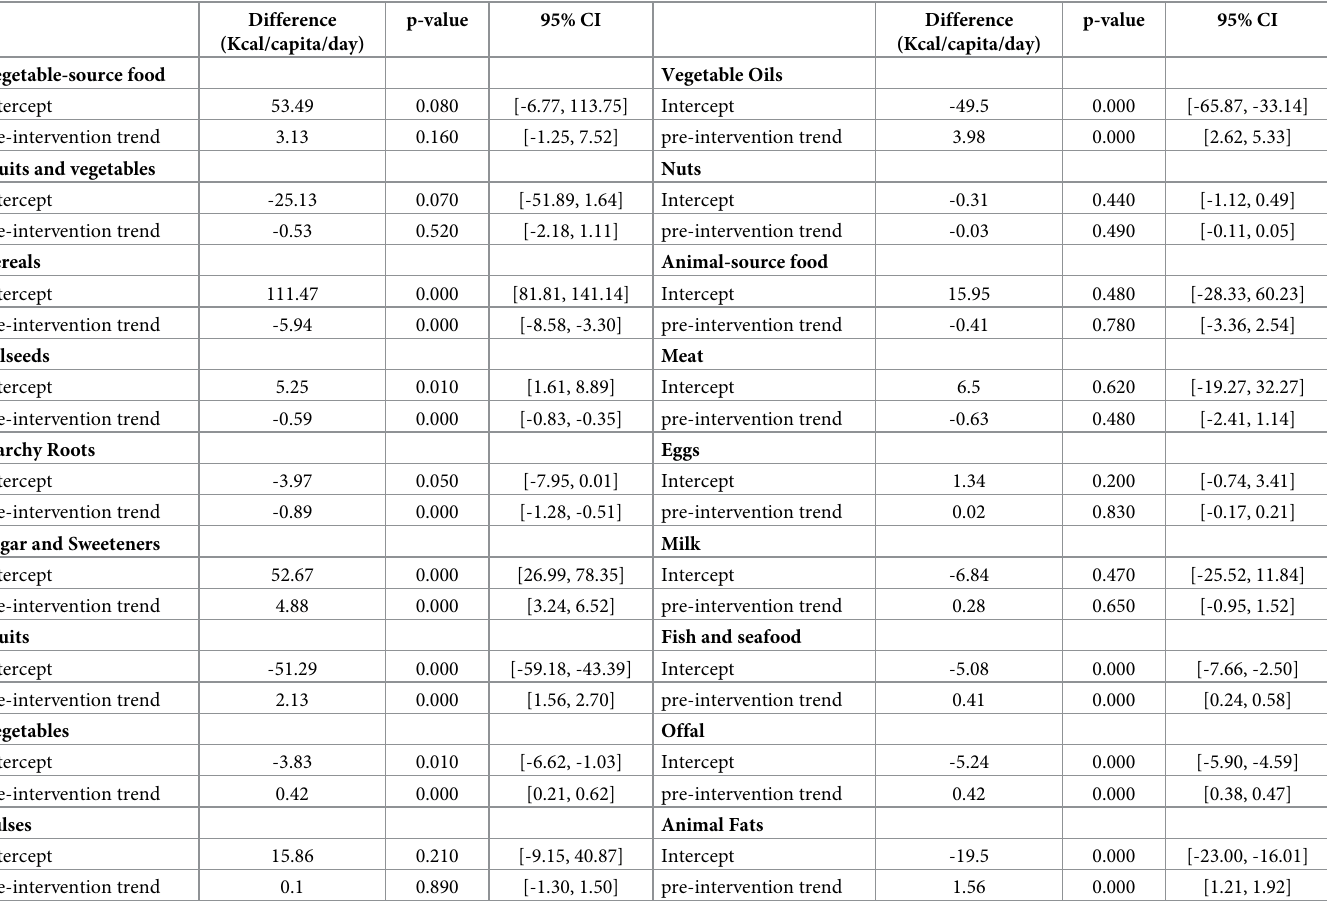
Table 2. Comparability between Mexico and the synthetic control by food group: Differences in the intercept and pre-intervention trend (1970–1993). Difference (Kcal/capita/day)